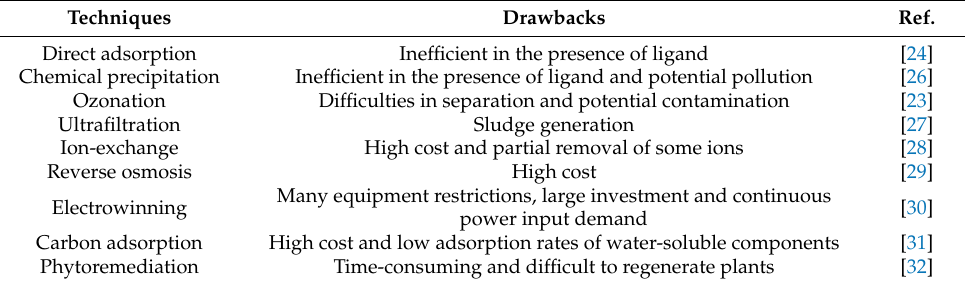
Table 2. Traditional heavy metal processing techniques and their drawbacks.